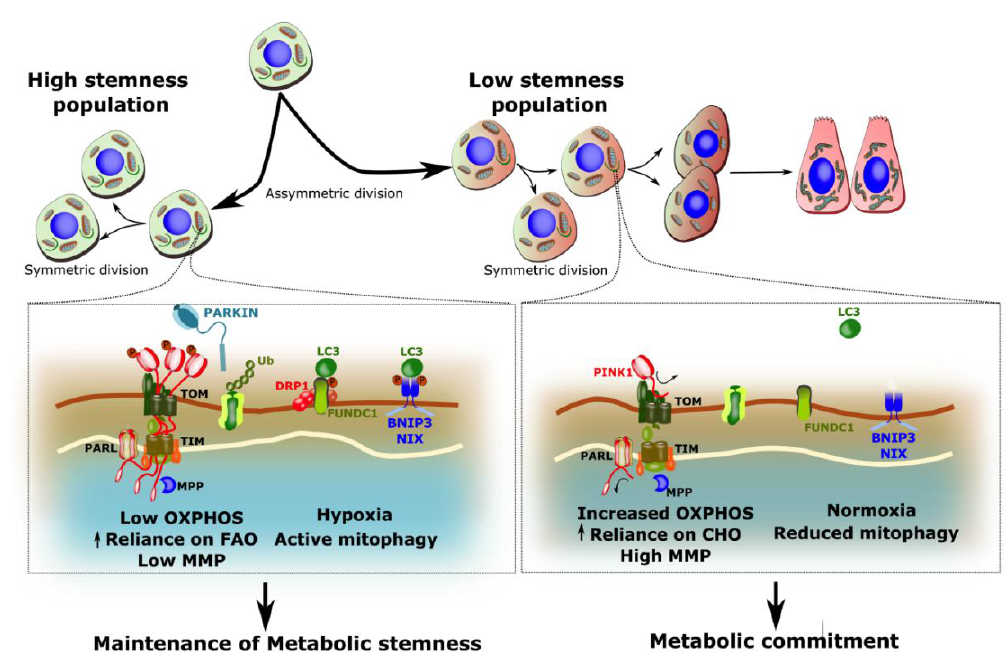
Figure 3. Model presenting potential mechanisms linking mitophagy to the metabolic landscape of stem cells versus committed cells. Mitochondria within stem cell populations have low rates of OXPHOS, predominantly use Fatty Acid Oxidation (FAO), and are partially depolarized (low MMP). Mechanistically, this can promote PINK1 import into mitochondria, leading to their clearance through PARKIN-mediated mitophagy. Furthermore, oxygen levels is suggested to be low (hypoxia) in specific stem cell niches such as bone marrow, which may increase the expression and recruitment of hypoxia-inducible mitophagy regulators, such as BNIP3 and FUNDC1 [24,25,106]. In this model, sustained mitophagy would enable pruningof the mitochondrial pool, and maintenance of metabolic stemness. Conversely, transition to increased OXPHOS, de-repression of pyruvate oxidation, high MMP, and higher oxygen levels (normoxia) result in the inhibition of mitophagy in order to facilitate the shifting metabolic profile committing cells. Based on this model, specific impairment of mitophagy is thus predicted to promote premature commitment and impair long-term maintenance of the stem cell pool. (Ub,